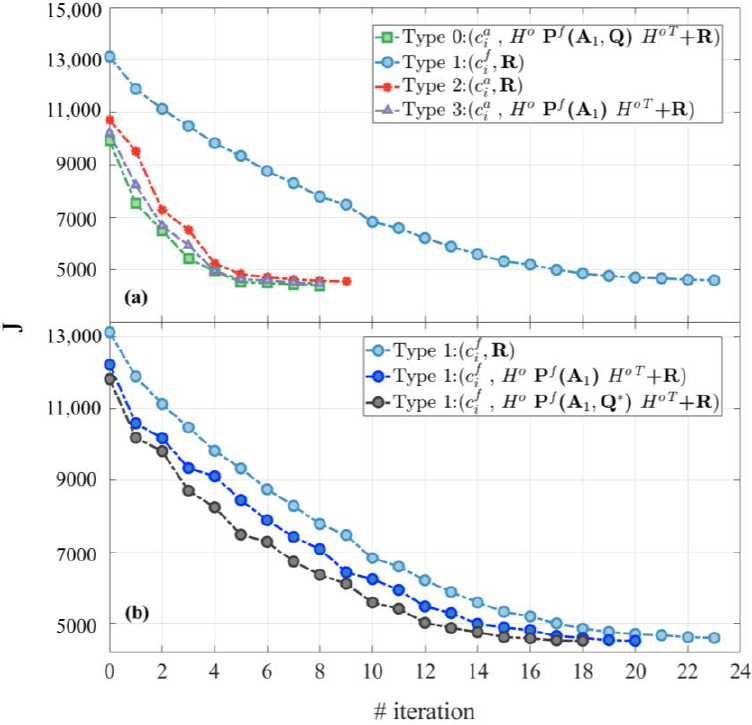
Figure 9. ( a ) Comparison between the value of cost function against the number of iterations to show the required computational time of four different inversion types (Type 0–3); ( b ) Comparison between the computational time of inversions when the initial field is provided with the model forecast ( c f ) for all the cases (Type 1 inversion); however, the impact of adding only error statistics to the cost function is shown.